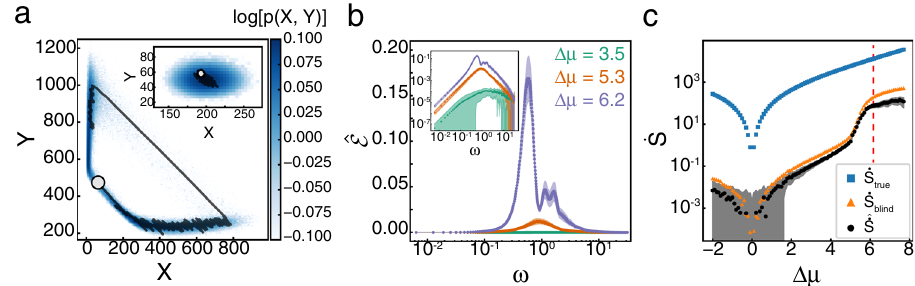
Fig. 2 _ S and E for well-mixed Brusselator. a Typical trajectory in ( X , Y ) space for Δ μ = 6.2. The occupation probability distribution is shown in blue, with a subsection of a typical trajectory shown in black. The end of the trajectory is marked by the white circle. Inset shows the same information for the system at equilibrium, where Δ μ = 0, with the same colorbar as the main fi gure. b ^ E for Δ μ = [3.5, 5.3, 6.2] shown in green, orange, and purple, respectively. Shaded area shows mean ± s.d. of ^ E for N = 50 simulations. ^ E is symmetric in ω , so only the positive axis is shown. Inset shows the same curves on a log- log scale. c _ S as a function of Δ μ . Blue squares, orange triangles, and black circles show results for _ S true , _ S blind , and ^_ S ± s.d. of for N = 50 simulations. Vertical red dashed line indicates Δ μ HB . See Supplementary Table 2 for all simulation